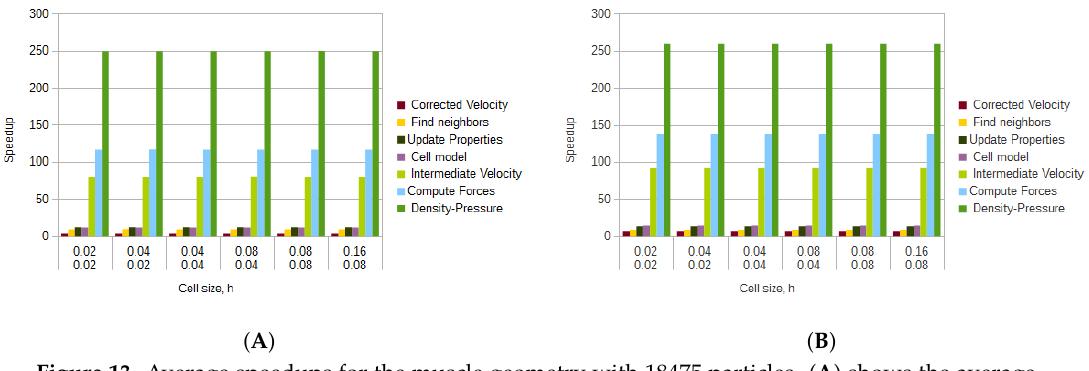
Figure 13. Average speedups for the muscle geometry with 18475 particles. ( A ) shows the average speedups for the triceps, ( B ) shows the average speedups for the vastus lateralis.